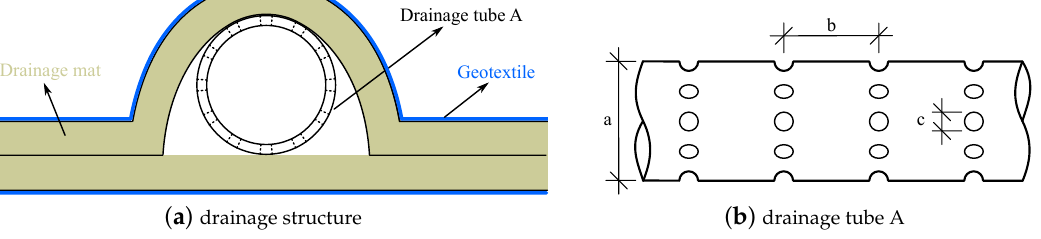
Figure 1. The drainage structure combining drainage mat, drainage tube, and geotextile, and the schematic diagram of drainage tube